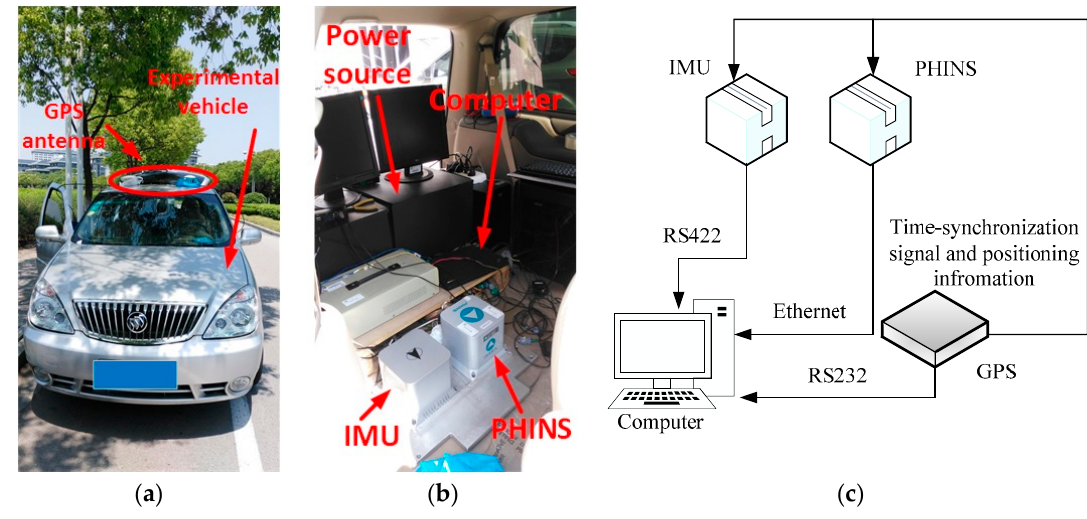
Figure 16. ( a ) Experimental vehicle; ( b ) SINS and PHINS; ( c ) construction of the vehicle test. Before the test, the installed error between IMU and PHINS are corrected, and the IMU system errors, such as the coupling coincident scale factors of the inertial sensors, are also corrected by the calibration methods. In Figure 17, the curves and trajectory of vehicle motion are depicted, and the field test is proceeded on our campus. The velocity of the vehicle is under 10 m/s.